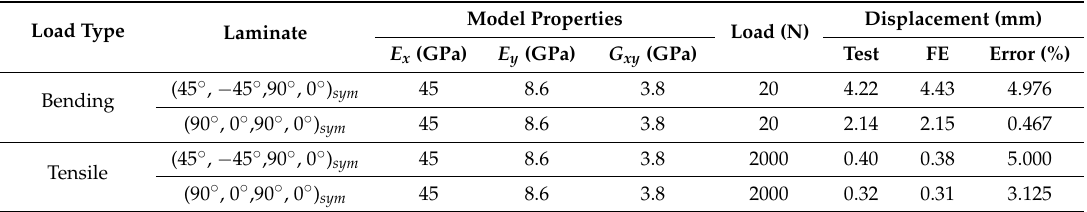
Table 1. A comparison between the experiments results and the finite element analysis.